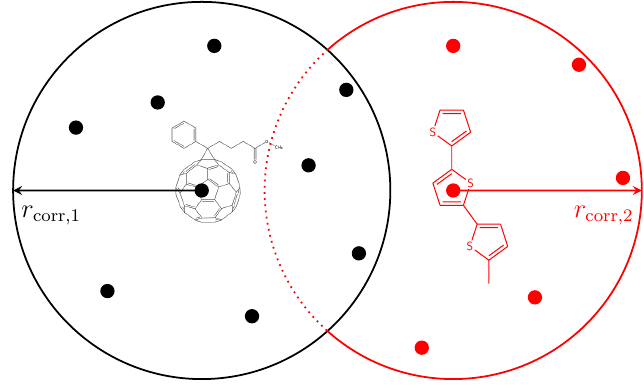
Figure 4. Correlation of site energies inside a blend. The black and red dots represent lattice sites of the small molecule PCBM and the polymer P3HT, respectively. A weighted average is performed over all sites of the same material type within the radius of r corr, i